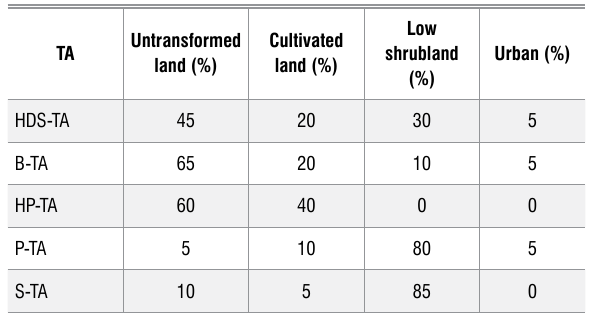
The percentage of land in each target area occurring in the categories identified by the 2013–2014 National Land Cover map 19 created by the South African Department of